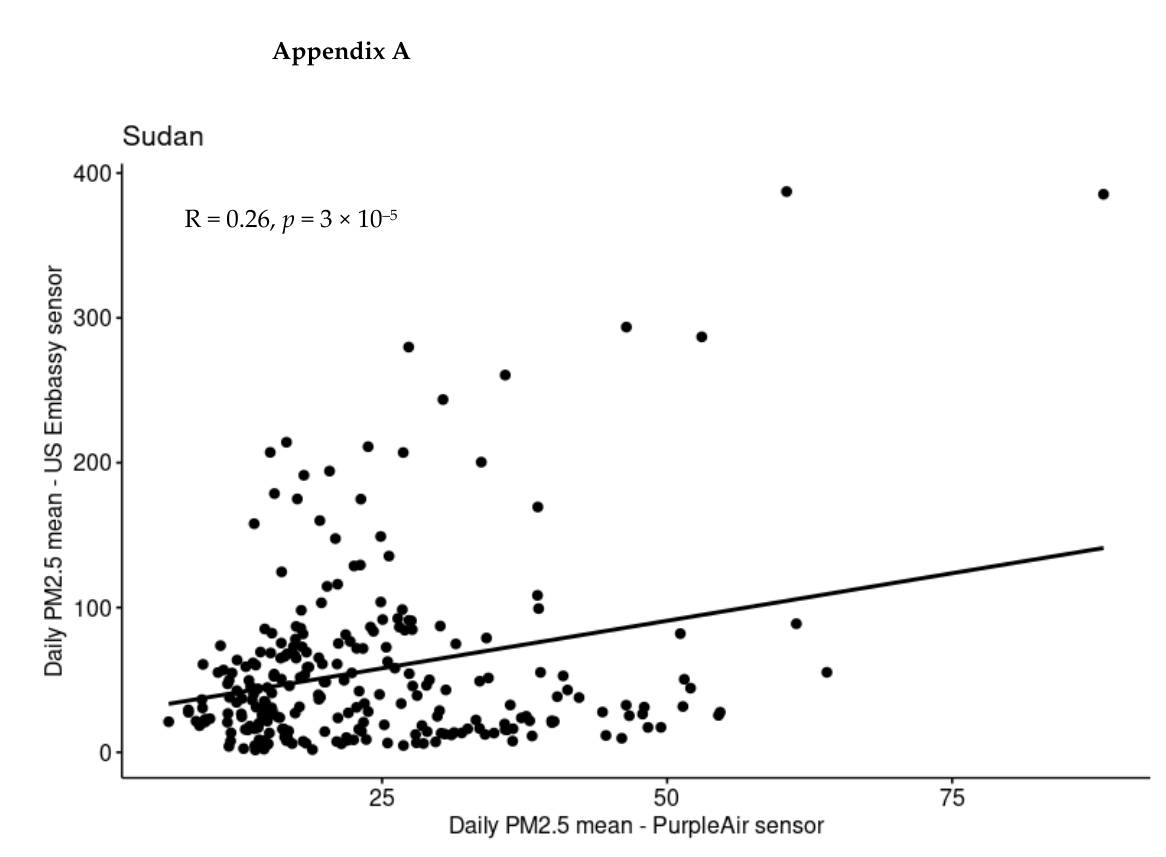
Figure A1. Correlation between the daily mean outputs of the US Embassy BAM and the Purple Air device in Khartoum, Sudan.